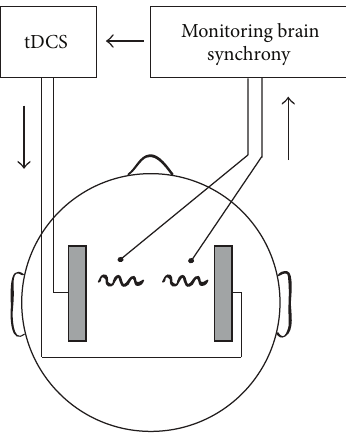
Figure 3: Using brain activity as a “biomarker”. We hypothesize that choosing tDCS parameters to maximize synchrony between cortical areas could lead to improved communication between the affected areas and thus result in more effective stroke